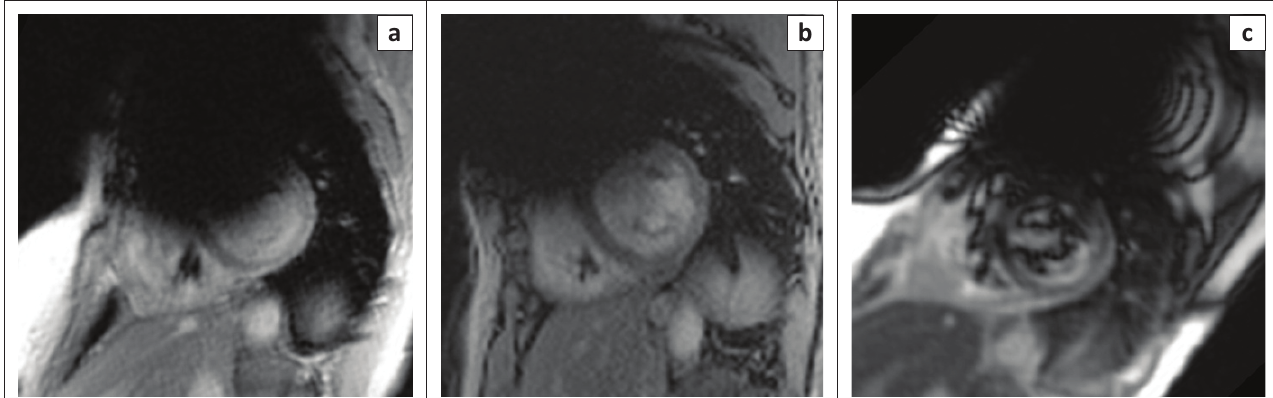
FIGURE 2: Effect of bandwidth on artifact: (a) Non-balanced gradient echo cine with low bandwidth (250 Hz/pixel); (b) Increasing bandwidth to 600 Hz/pixel allows visualisation of more of the heart. (c) Real-time SSFP cine sequence has more severe artifact.